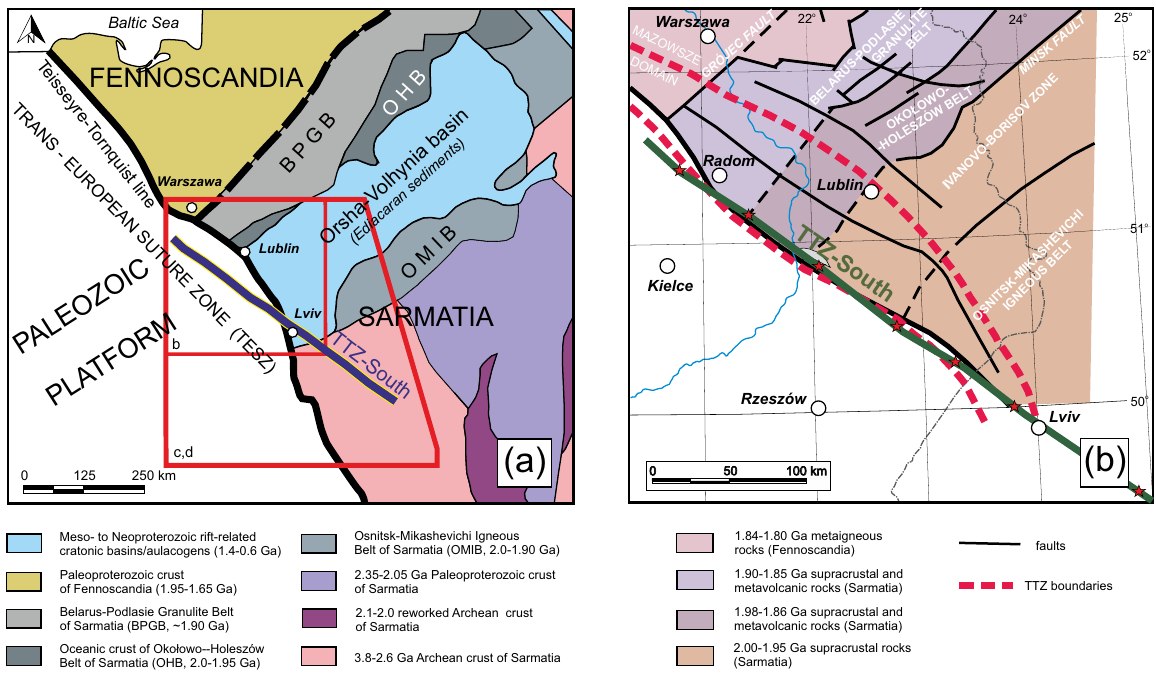
boundaries1.84-1.80 1.90-1.85 Ga supracrustal and metavolcanic rocks (Sarmatia) 1.98-1.86 Ga supracrustal and metavolcanic rocks (Sarmatia) 2.00-1.95 Ga supracrustal rocks (Sarmatia)3.8-2.6 GaArchean crust of Figure 2. Tectonic setting of the TTZ-South profile: ( a ) in the context of major basement domains at SW margin of the East European craton (EEC) shown on map by Bogdanova et al. (ref [23] simplified by M˛e˙zyk et al. [24]) and ( b ) on the top of crystalline basement outline map of the East European platform by Krzemi´nska et al. (ref [25] modified after M˛e˙zyk et al. [24]). The red square shows the location of Figure 2b. The TTZ boundaries in ( b ) are shown according to Mazur et al. [9] and Mikołajczak